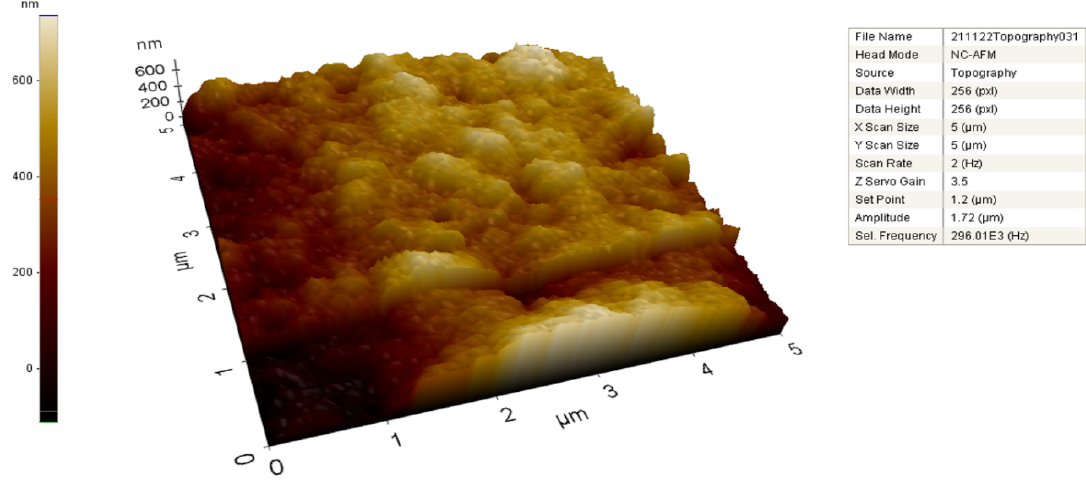
Figure 4. AFM image of AgNPs synthesized from A. cepa peel